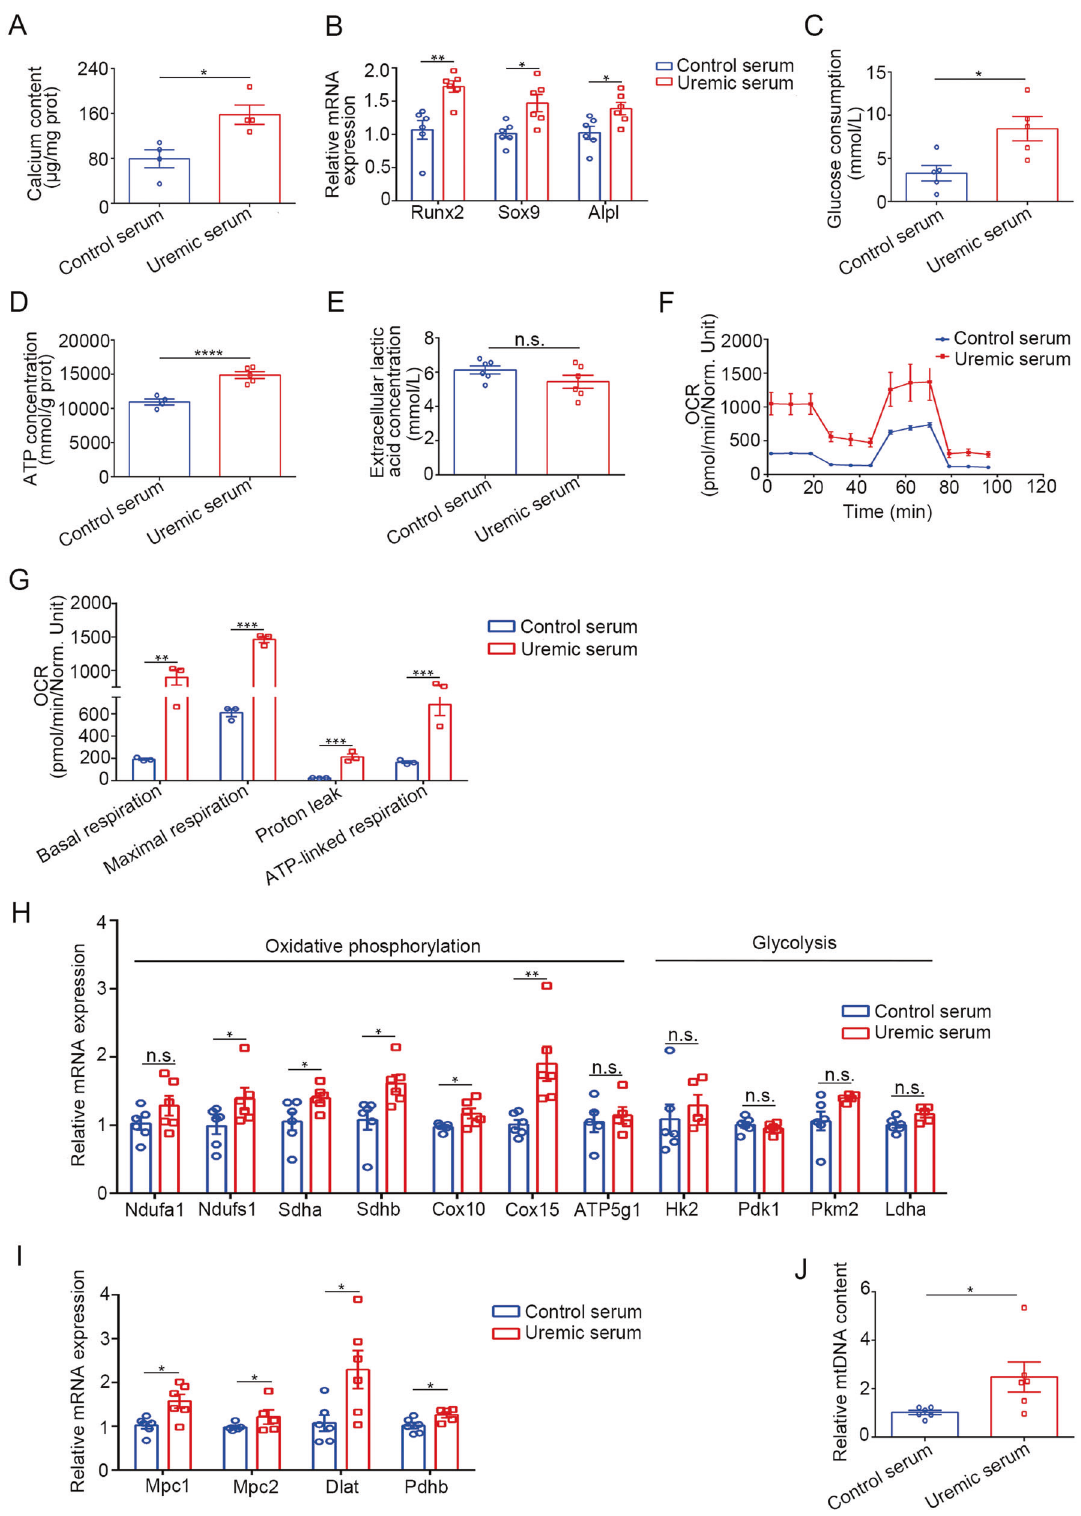
Fig. 3 OXPHOS was enhanced in uremia-related calci fi cation. HASMC were cultured in medium treated with serum from healthy control or uremic patients. A Total calcium content in HASMC (unpaired t test; n = 4). B Relative mRNA expression of Runx2, Sox9, ALPL in HASMC as detected by RT-qPCR (unpaired t test; n = 6). C Relative glucose consumption of HASMCs (unpaired t test; n = 5). D ATP concentration of HASMC (unpaired t test; n = 5). E Extracellular lactic acid concentration of HASMC (unpaired t test; n = 6). F OCRs were measured in HASMC ( n = 3). G Basal respiration, maximum respiration, proton leak, and ATP-linked respiration in OCRs were analyzed (unpaired t test; n = 3). H Relative mRNA expression of genes related to the in fl ux of pyruvate into mitochondria (unpaired t test; n = 5 – 6). I Relative mRNA expression of OXPHOS-related and glycolysis-related genes in HASMCs as detected by RT-qPCR (unpaired t test; n = 6). J Relative mtDNA content (unpaired t test; n = 6). * P < 0.05, ** P < 0.01, *** P < 0.001, **** P < 0.0001, n.s. not signi fi cant. Cell Death and Disease (2022)